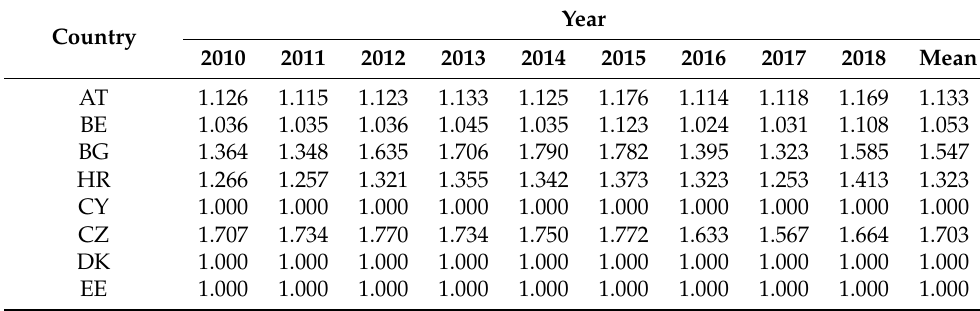
Table A7. Efficiency scores across countries.